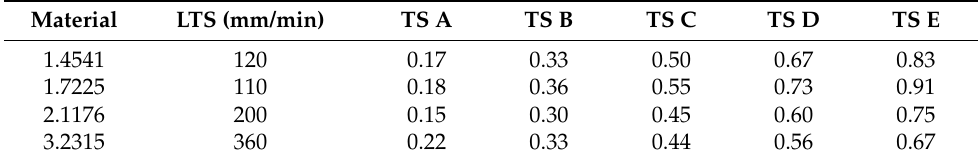
Table 4. Limit traverse speed (LTS) and the traverse speed ratios for selected values of TS.